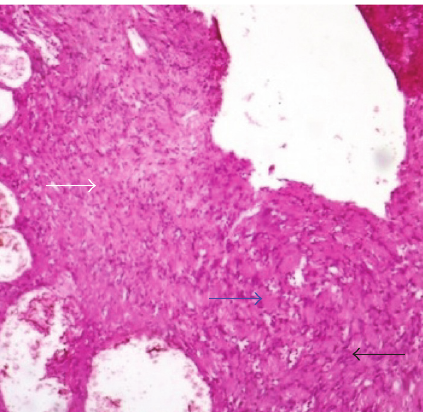
Figure 7: Histological features (H&D × 40) show Antoni-A areas (black arrow), Antoni-B areas (white arrow), and Verocay bodies (blue arrow).